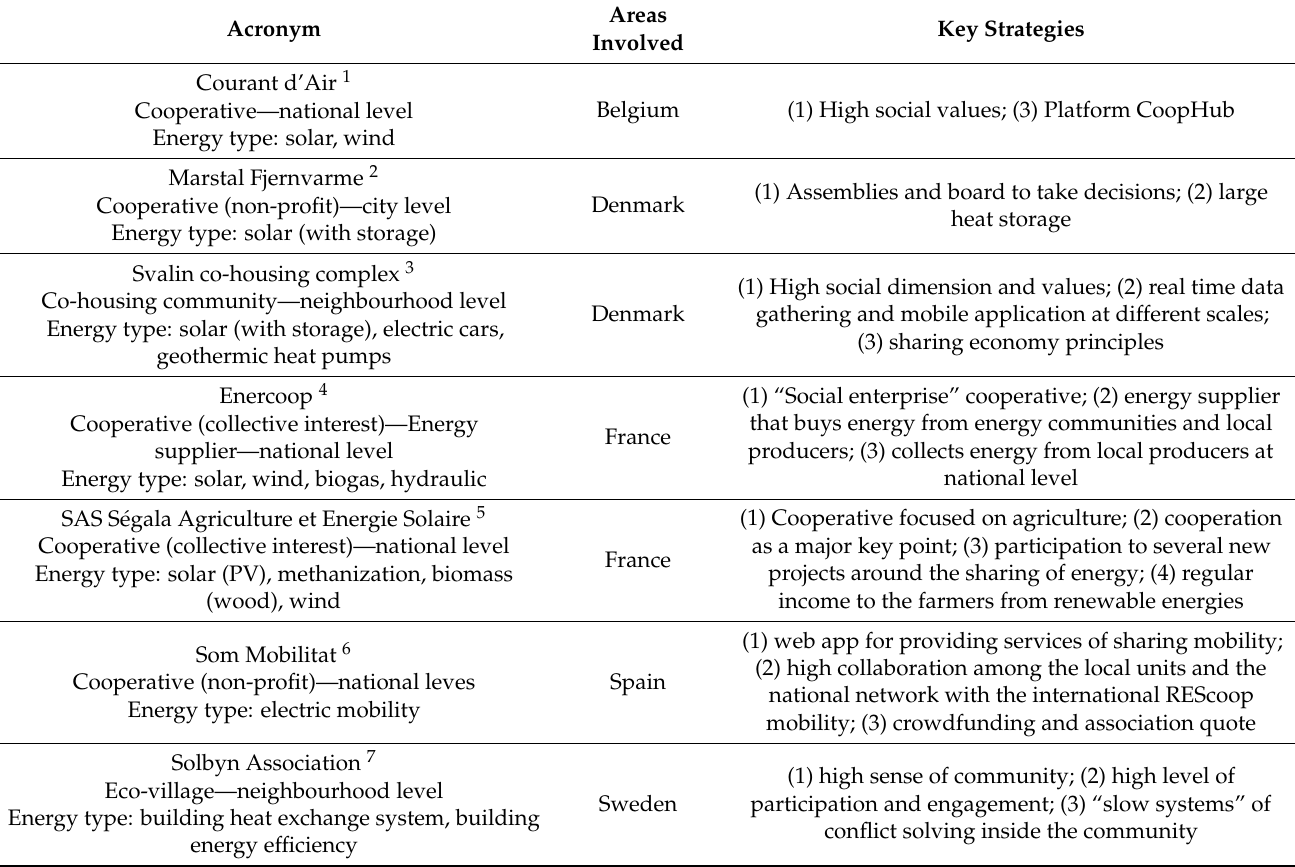
Table 2. A qualitative overview of energy communities in Europe (some of the first experiences not necessarily linked with EU